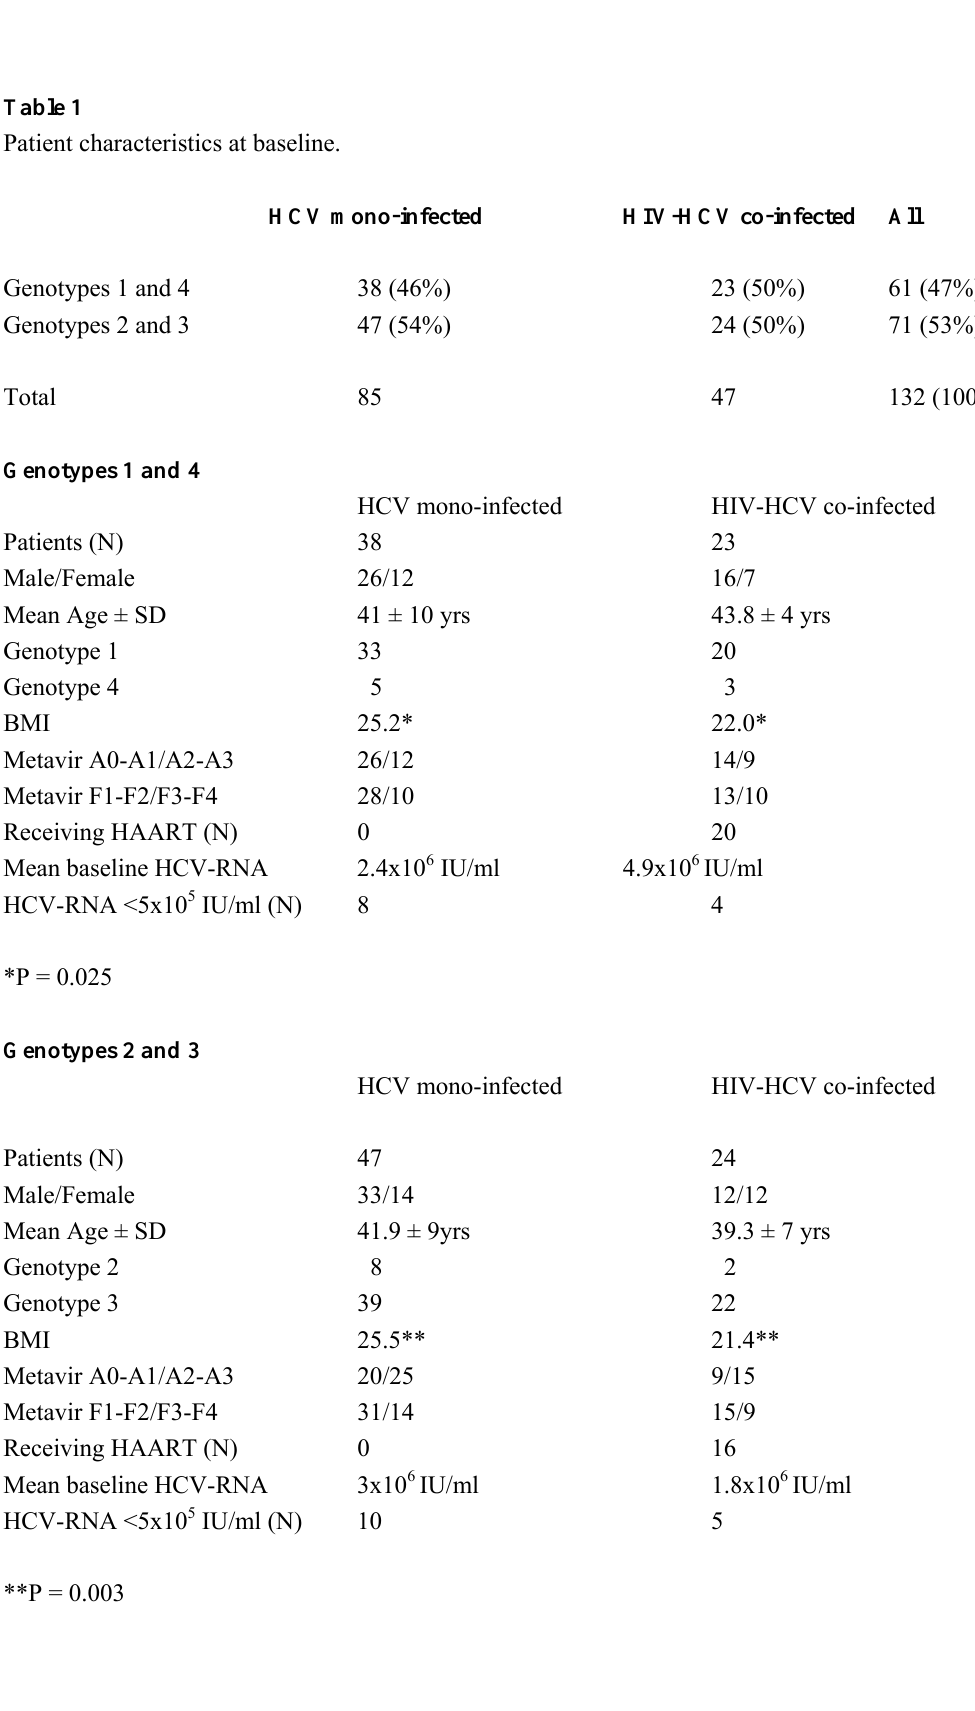
Table 1 Patient characteristics at baseline. HCV mono-infected HIV-HCV co-infected